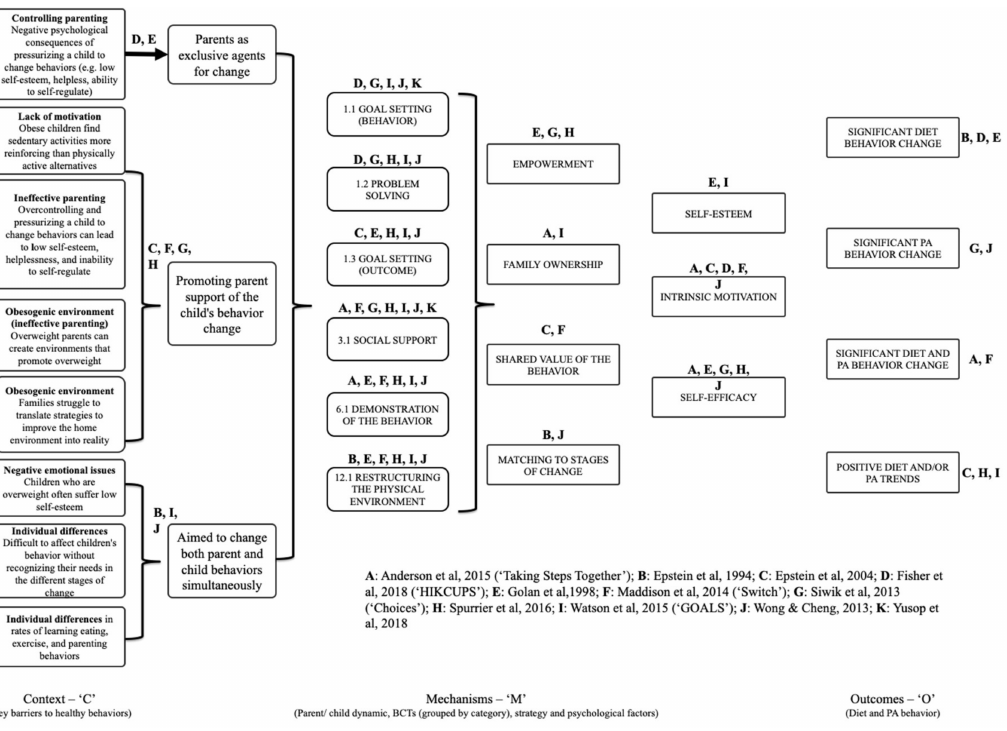
Figure 3. Final program theory. A: [44] (‘Taking Steps Together’); B: [45]; C: 46; D: [47]